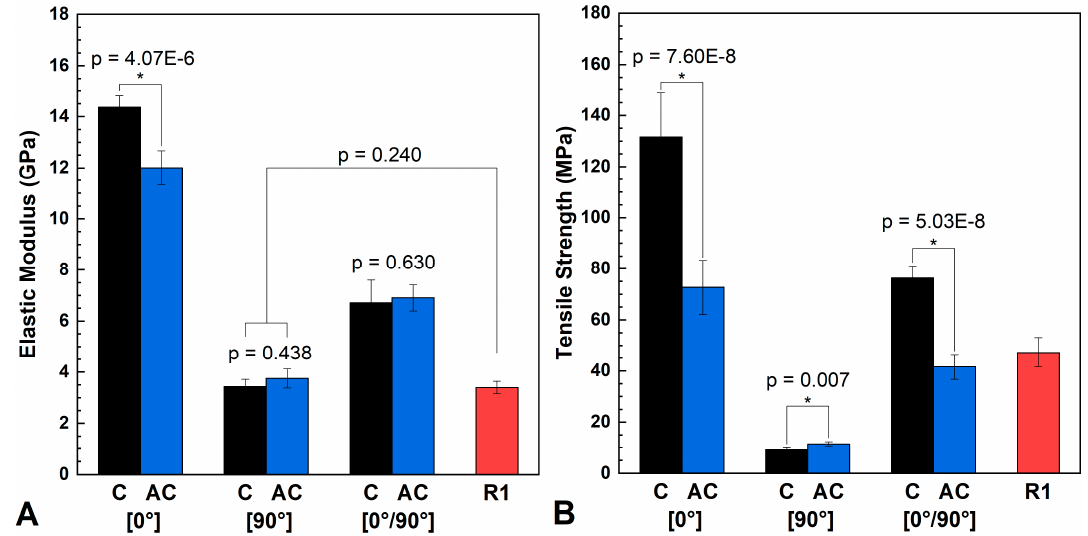
Figure 4. ( a ) Experimental tensile elastic moduli and ( b ) tensile strengths of C, AC, and resin (R1) samples (“p” denotes p-value for the conducted ANOVA). Table 3. Experimental results and input parameters for the mechanical models.